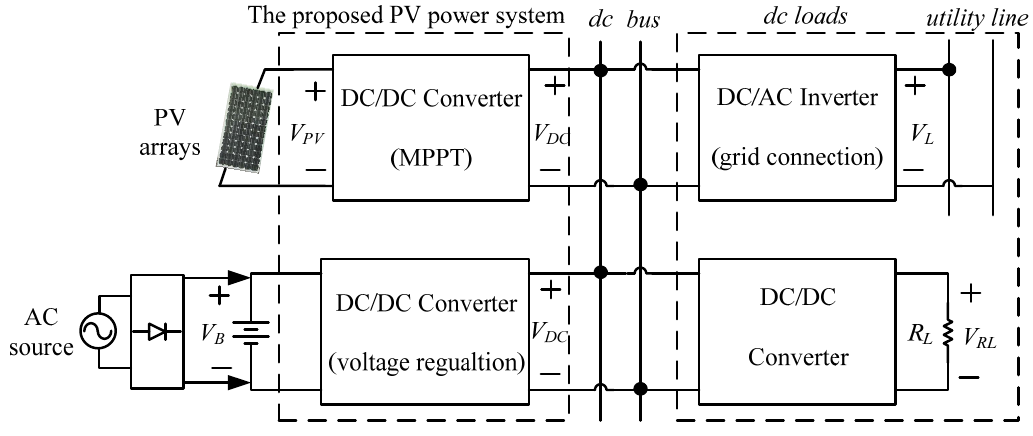
Figure 1. Block diagram of PV power generation system for DC load